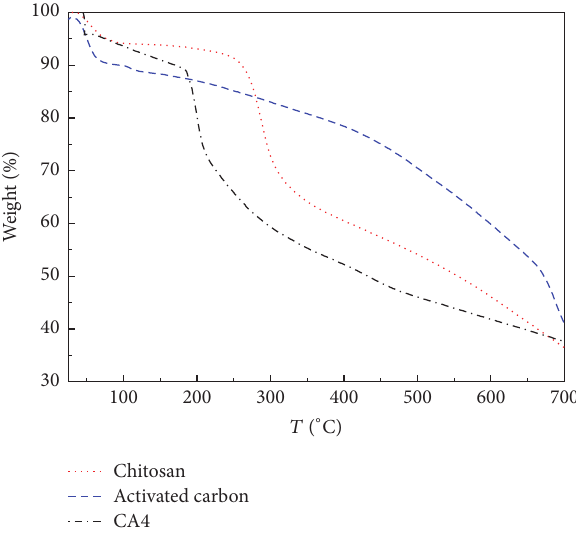
Figure 4: TG of chitosan, activated carbon, and CA4.